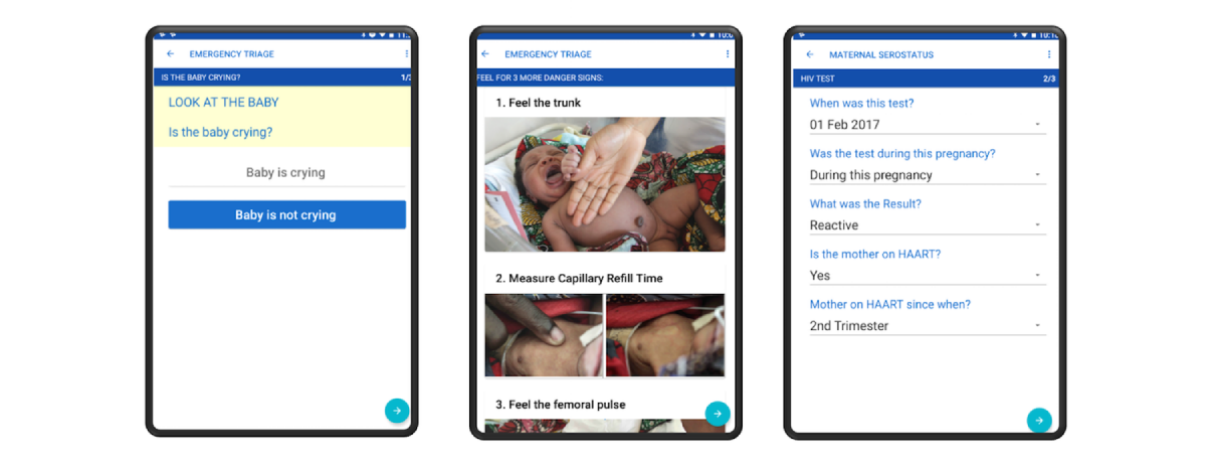
Figure 2. Example app